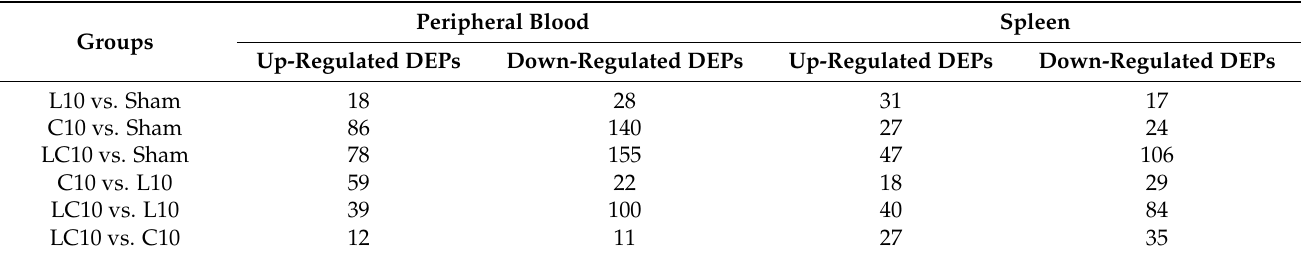
Table 4. The number of differentially expressed proteins (DEPs) after compound microwave exposure in peripheral blood and the spleen.